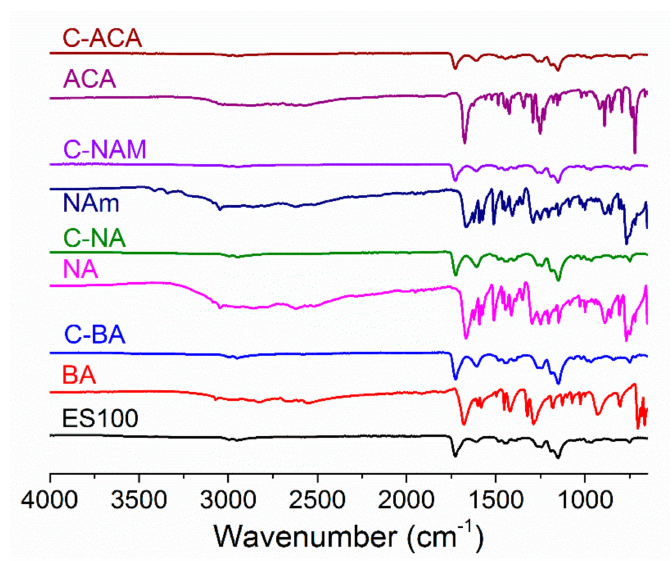
Figure 8. IR spectra of the coaxial fibers.